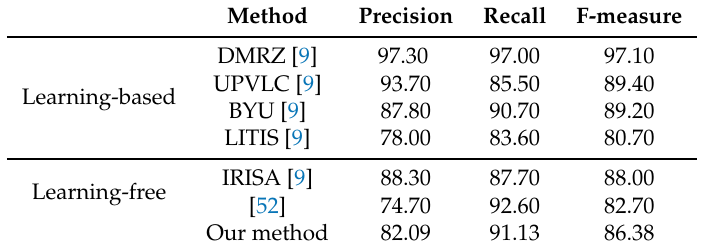
Table 6. Comparison of our results with the cBAD competition results and another recent work.